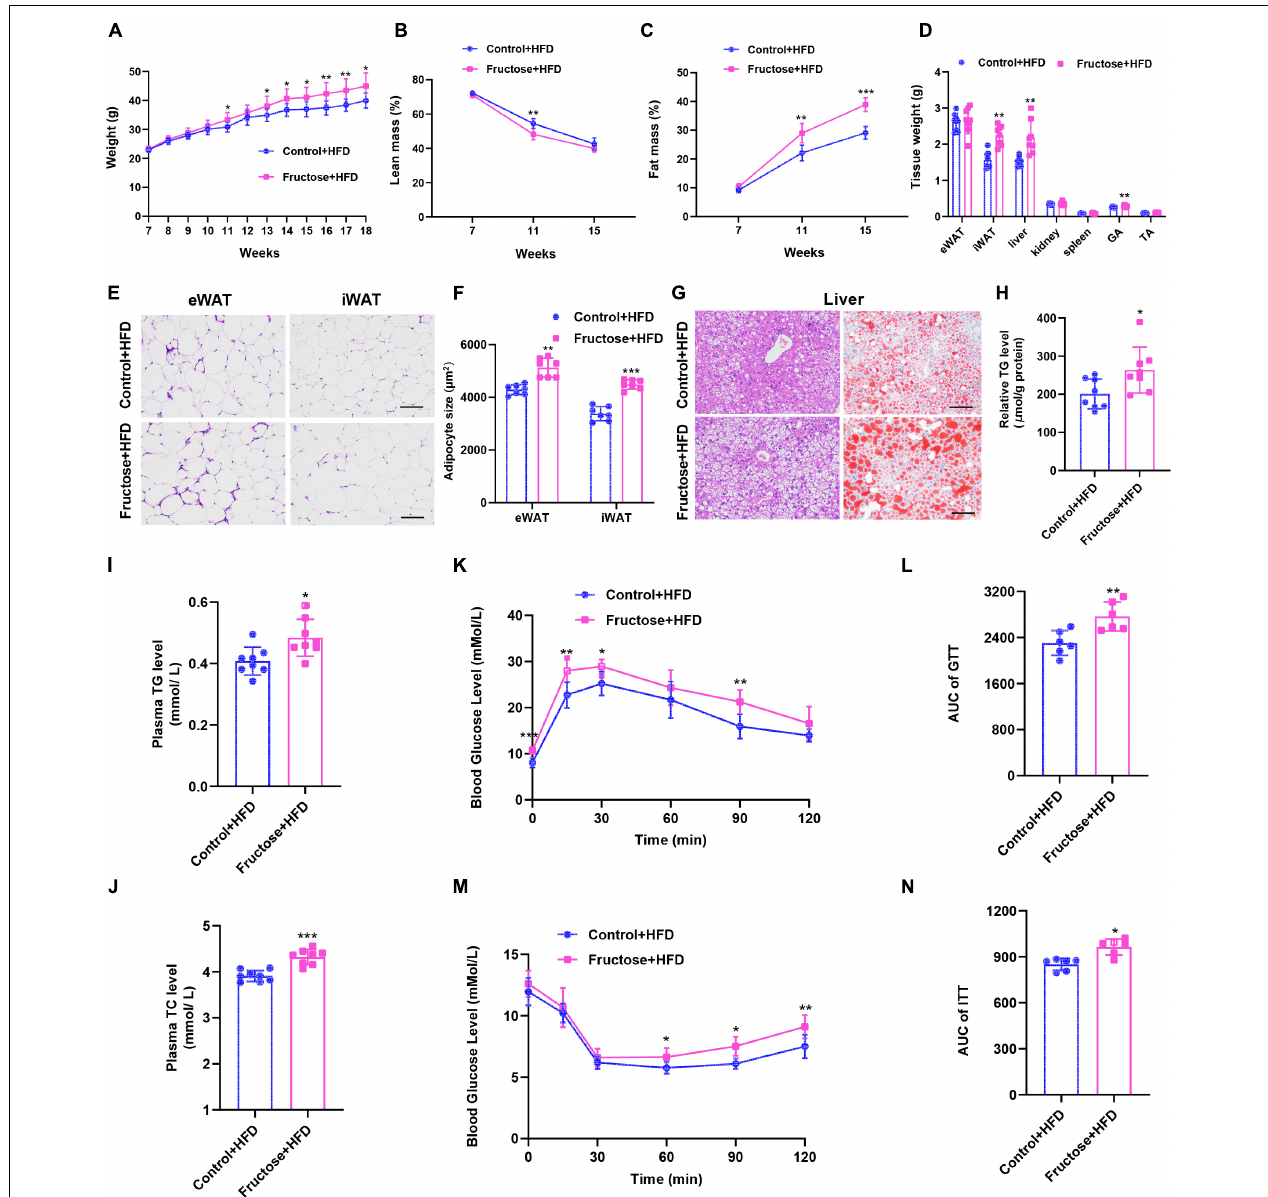
FIGURE 2 | Maternal high-fructose intake during pregnancy predisposes adult offspring to HFD-induced obesity, fatty liver, and insulin resistance. All data were from the HFD-fed control offspring and HF offspring. (A) Bodyweight curve of the offspring. (B,C) Relative body composition of the offspring. (D) Tissue weights of the offspring. (E) H&E staining of paraffin sections of inguinal white fat (iWAT) and epididymal white fat (eWAT). Scale bar, 100 µ m. (F) Quantification of average adipocyte area from images depicted in (E) . (G) H&E staining of paraffin sections of liver and Oil Red O staining of frozen section of the liver. Scale bar, 100 µ m. (H) Quantification of triglyceride content in liver ( n = 8). (I,J) Plasma concentrations of triglyceride (TG) and total cholesterol (TC) ( n = 8). (K) Blood glucose concentrations during glucose tolerance test ( n = 6). (L) Quantification of the area under the curve of (K) ( n = 6). (M) Blood glucose concentrations during insulin tolerance test ( n = 6). (N) Quantification of the area under the curve of (M) ( n = 6). * p < 0.05, ** p < 0.01, *** p <